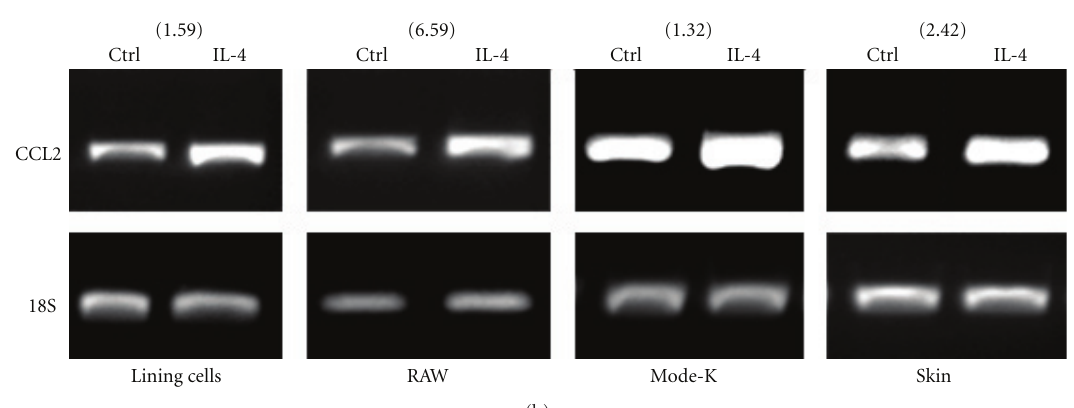
Figure 5: Expression of CCL2 mRNA in di ff erent cell populations. (a) air pouches were created and IL-4 or bu ff er was administered for 6 hours. Cells were harvested, pooled ( n = 6) and CCL2 (MCP-1) mRNA were detected as described in Materials and Methods. (b) Murine air pouches were created and the lining cells and skin cells were harvested as described in Materials and Methods. Lining cells, skin cells, murine macrophages (RAW) and epithelial Mode-K cells were stimulated for 6 hours with bu ff er (Ctrl) or 250 ng/ml IL-4 and the expression of CCL2 mRNA was performed by RT-PCR. Results are from one representative experiment out of at least 3. Number between parentheses represents the ratio of the signal intensity of (IL-4/18S)/Ctrl/18S) obtained after densitometry analysis using a Fluor-S multi-imager (Bio- Rad, Hercules, CA) and the Multi-Analyst version 1.1